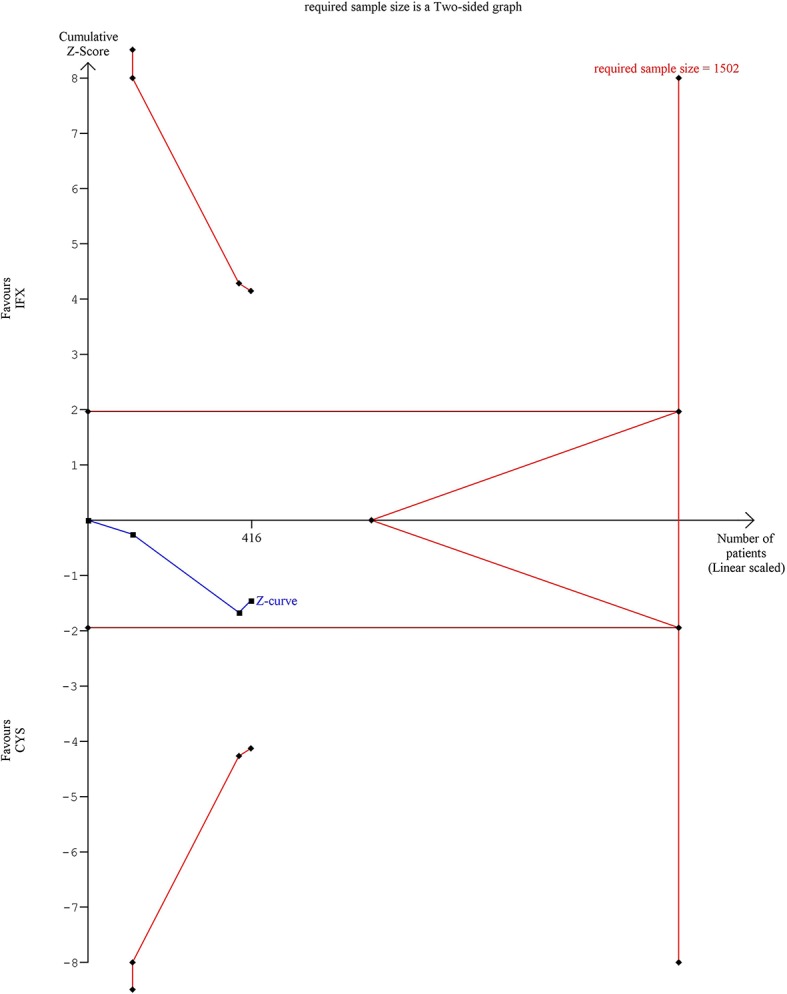
Results of the trial sequential analysis of the risks of 1 year colectomy-free rate. The required sample size of 1,502 patients was estimated using α = 0.05 (two-sided) and ß = 0.02 (power of 80%). Crossing of the constructed cumulative Z-curves (blue) and the two-sided Z = 1.96 provides a traditionally significant result. To obtain reliable evidence, crossing of the trial sequential monitoring boundaries (red) is needed. In the case of 1 year colectomy-free rate outcome, the cumulative Z-curve (blue) did not crossed the conventional boundary and neither the trial sequential monitoring boundary nor the required sample size line was surpassed.